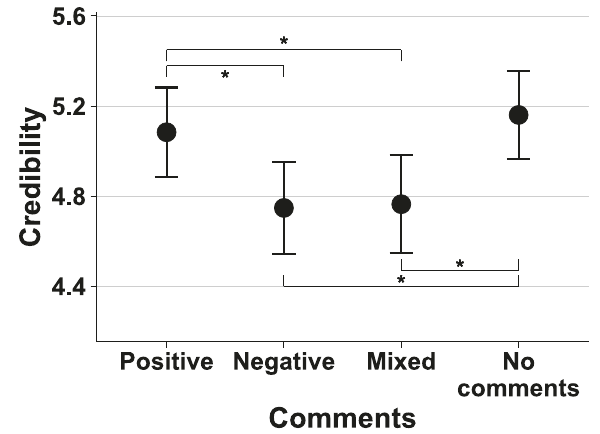
Fig. 8 Main effect of comment sentiment on credibility . Error bars represent 95% CIs, signi fi cant differences ( p < 0.011) are indicated with